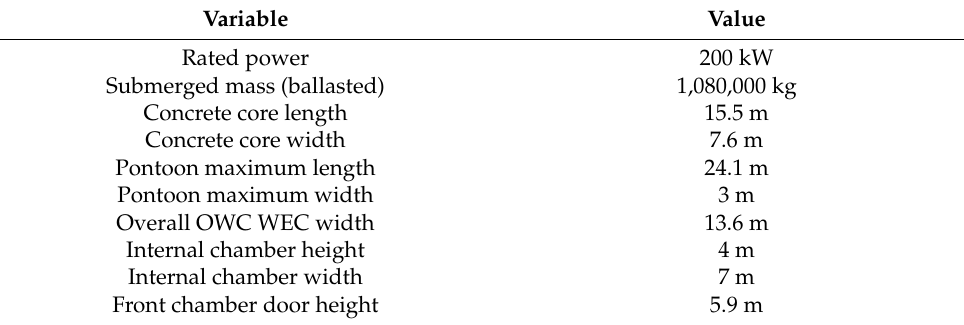
Table 1. King Island OWC WEC device details.